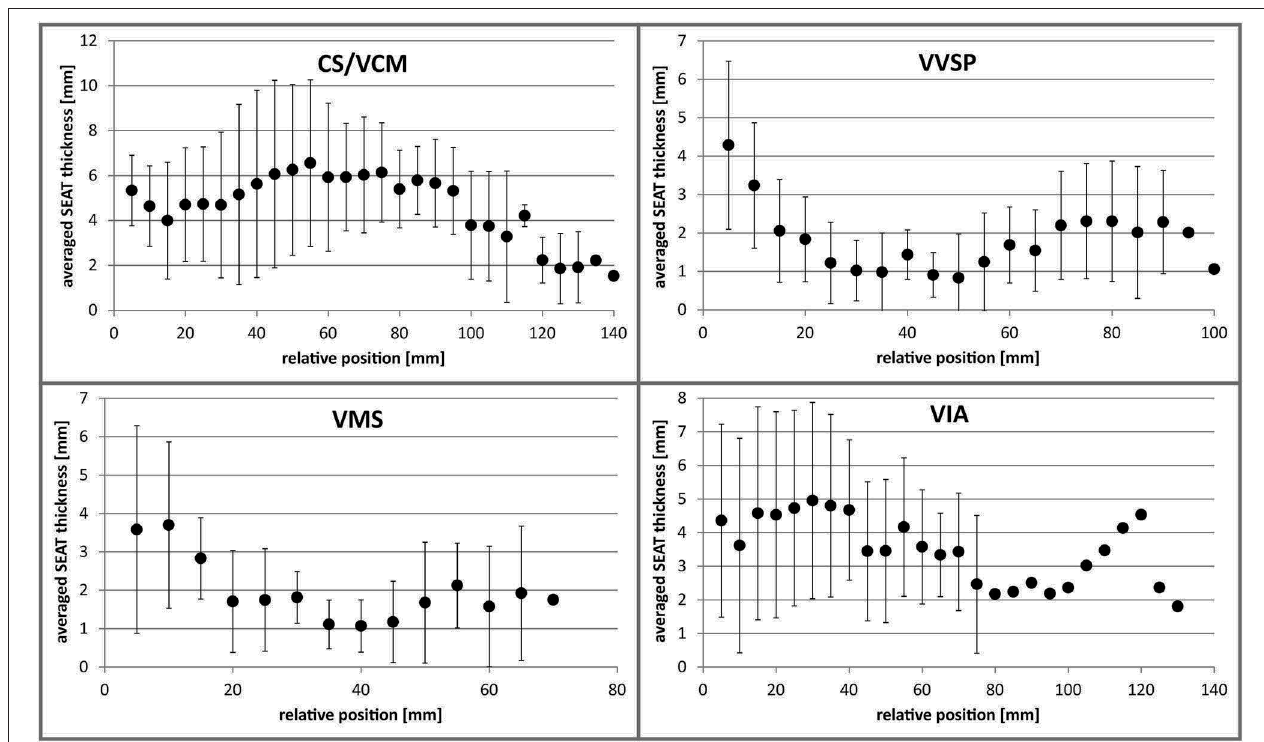
FIGURE 7 | Averaged SEAT thickness along the distance of the different coronary veins. Error bars indicate standard deviation. Distal values without error bars are single measurements. CS, coronary sinus; VCM, great cardiac vein; VIA, anterior interventricular vein; VMS, left marginal vein; VVSP, left posterior ventricular